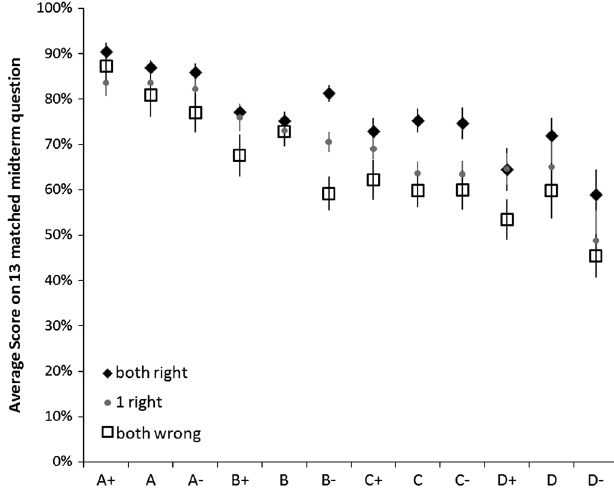
FIG. 6. Student performance on exam problems for topics the exam-prep tool predicted they would perform well on (dia- monds), and topics the tool predicted they would not perform well on (squares). The students are binned based on their grade in the prior semester (mechanics) physics course. For B þ through C (cid:1) students, performance on the practice tool is a better predictor of performance then their performance in the prior physics